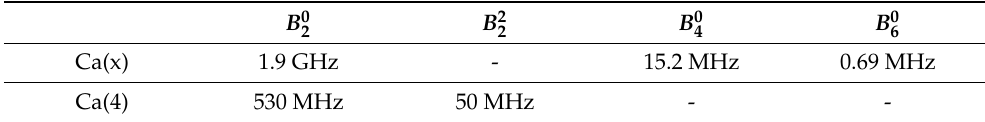
Table 1. The zero-field (fine structure) parameters of Gd 3+